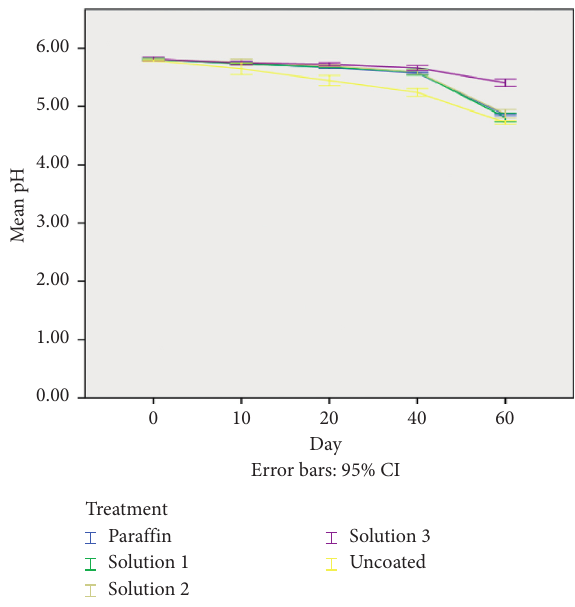
Figure 9: Values (means ± SD) of the pH of cheese coated with antimicrobial edible coating solutions—solution 1 (0.250g/L Delvocid), solution 2 (0.275 g/L Delvocid), and solution 3 (0.300 g/ L Delvocid)—compared with cheese coated with commercial coating and uncoated cheese throughout 60d of storage at 10 ° C and 85% relative humidity.